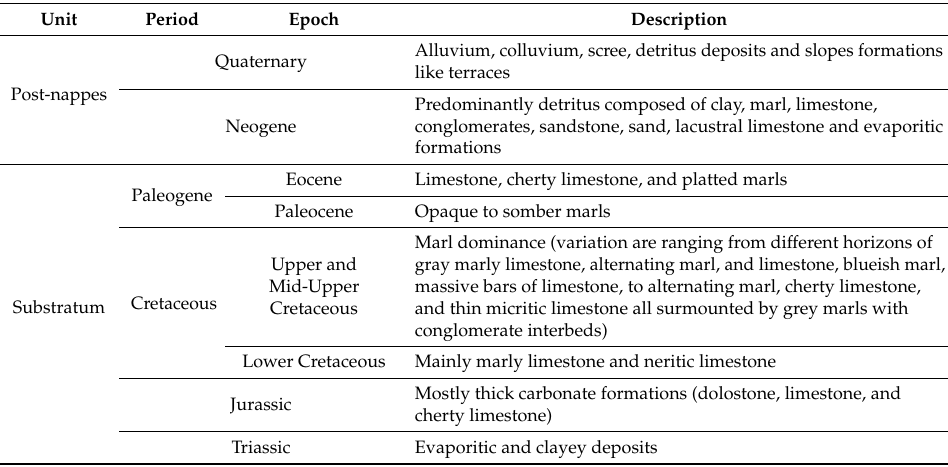
Figure 2. The geological map of the study area. Figure 2 . The geological map of the study area. Table 1. The outcropping geological formations in the study Table 1. The outcropping geological formations in the study area.